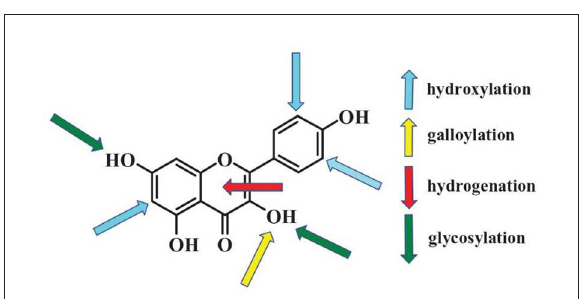
structure-function of polysaccharides toward enzymes activity has been not revealed yet.